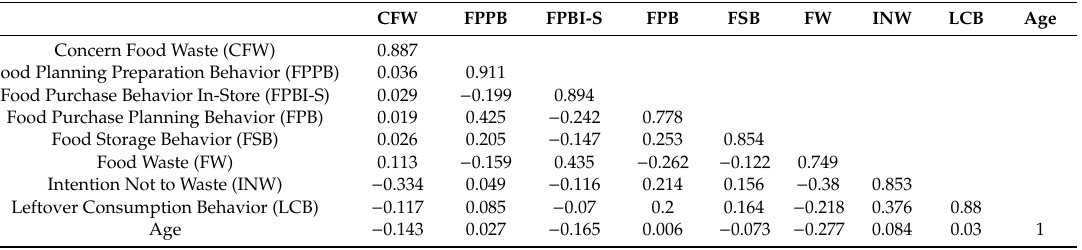
Table 4. Fornell–Larcker Criterion (in bold).